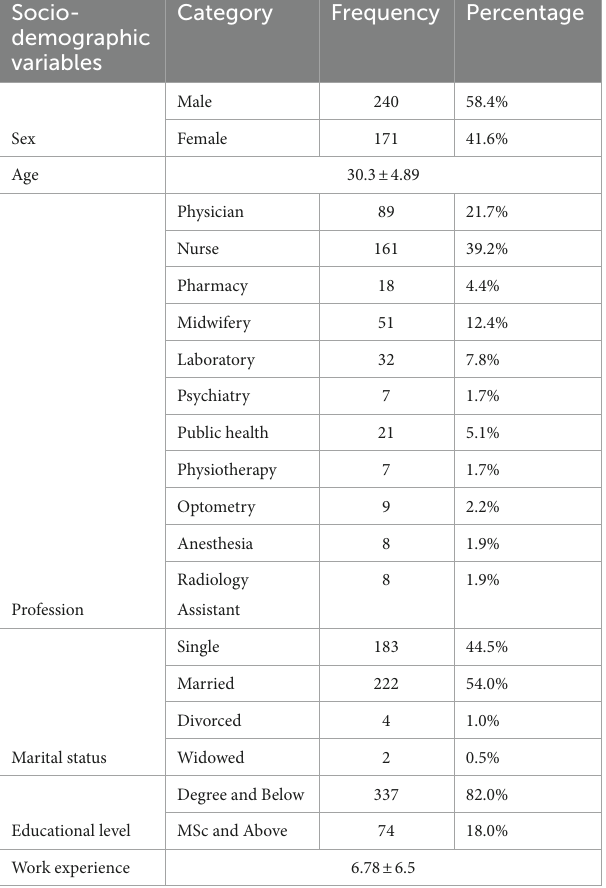
TABLE 1 Socio-demographic characteristics of respondents. Socio- demographic